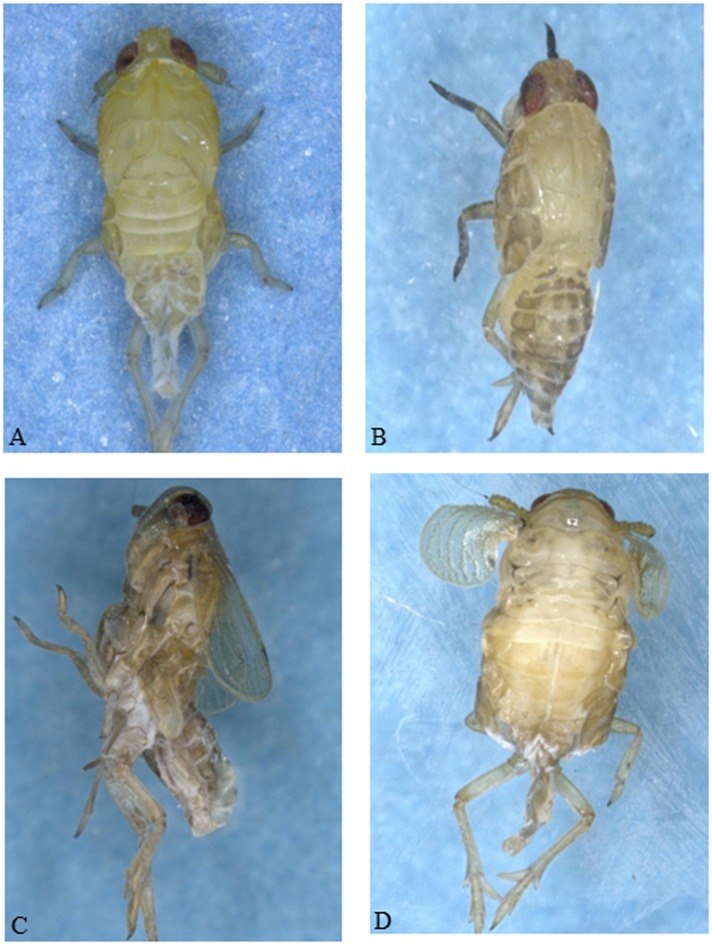
Effect of dsRNA injection on the nymphal molting.The typical phenotype of nymphs with silenced NlSRβ, NlSar1, NlArf6 or NlRab2 (A, B) which did not molt into next stage and old nymphal exoskeletons remained on the tips of legs and abdomens and died later. The typical phenotype of nymphs with silenced NlRheb, NlRab1, NlRab39 or NlRac (C, D) which started to ecdyse but failed to shed the exuvia completely and showed deficiencies in the extension of the wings.